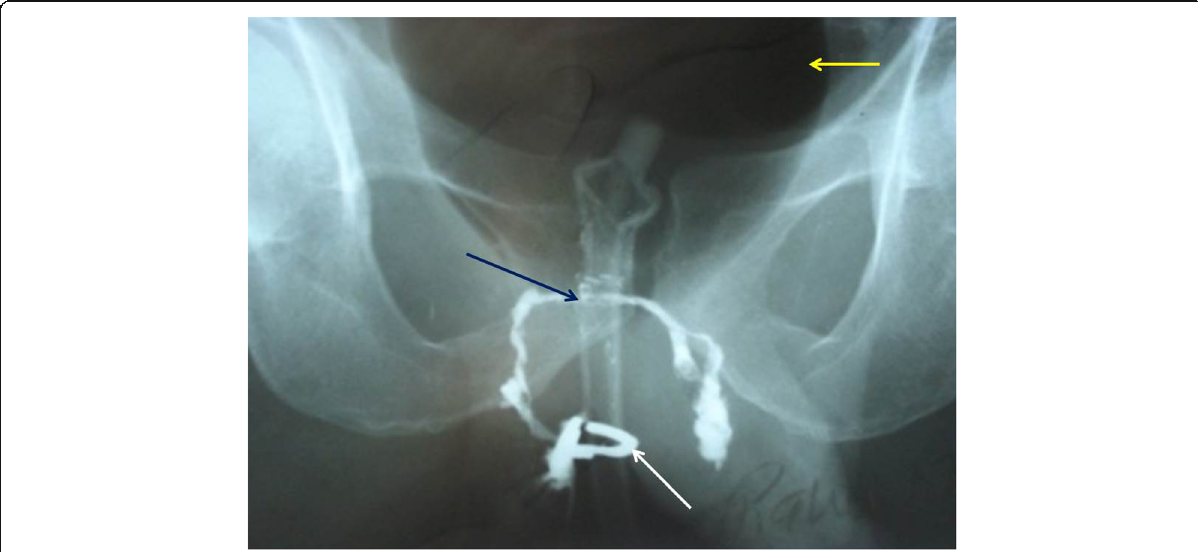
Fig. 4 X-ray fistulogram of a semi-horseshoe fistula showing Deshpande ’ s technique of double-contrast fistulography with malecot rubber catheter in the anorectal canal to fill air into the rectum (yellow arrow) with a metal marker at anal verge (white arrow). Blue arrow demonstrates the level of the anorectal junction